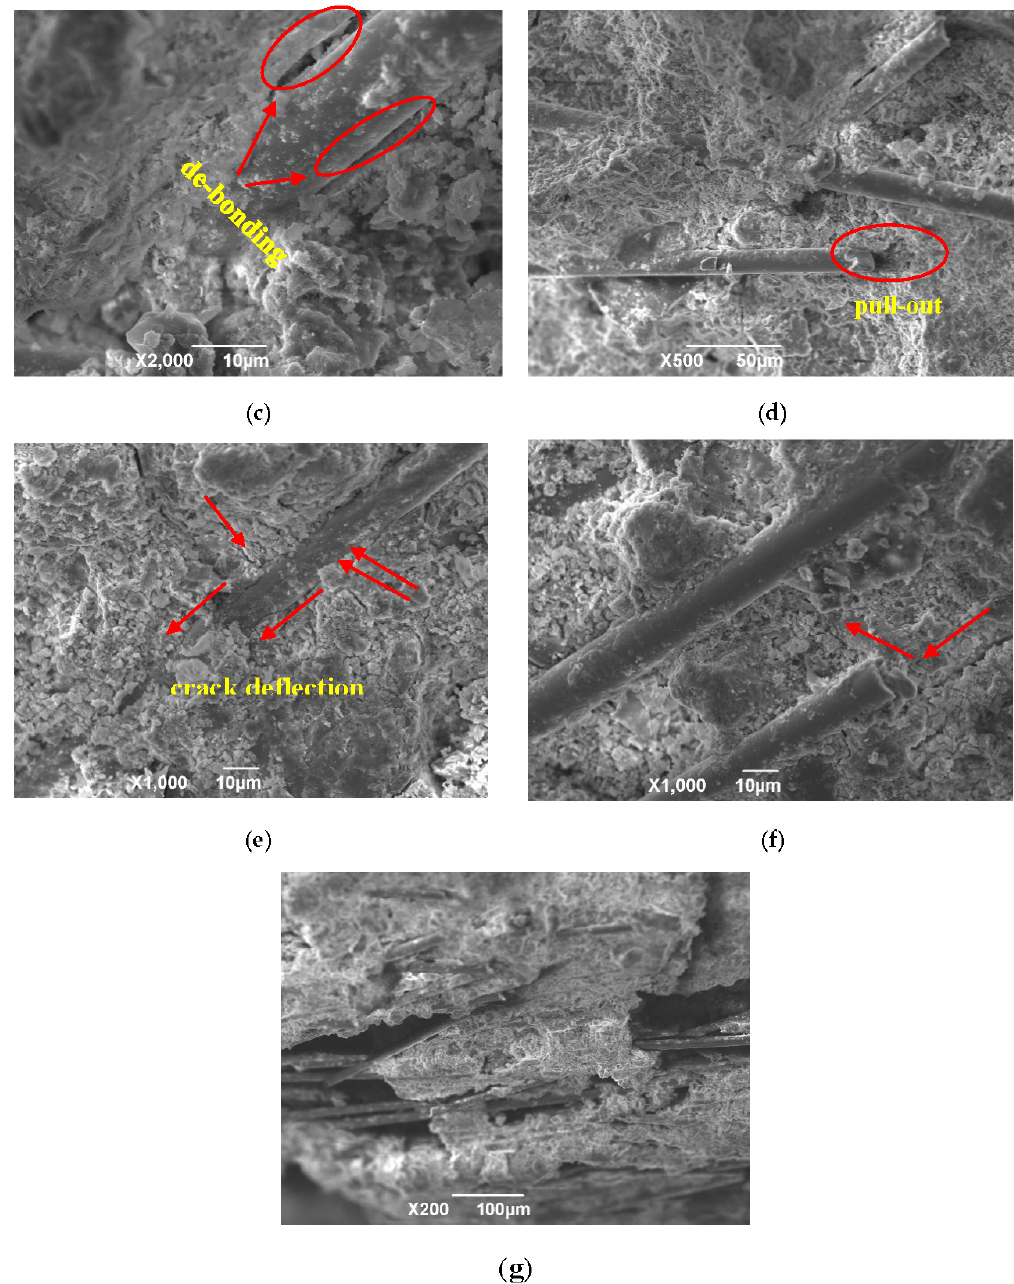
Figure 15. The SEM iamges of BFRCs: ( a , b ) show the SEM images of the BFRCs before fracture testing and ( c – g ) show the images of the BFRCs after fracture testing.